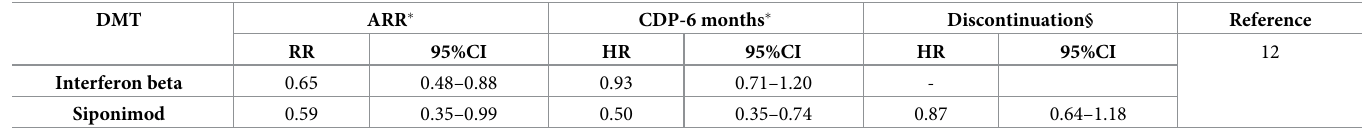
Table 2. Disease modifying therapies efficacy and discontinuation. DMT ARR